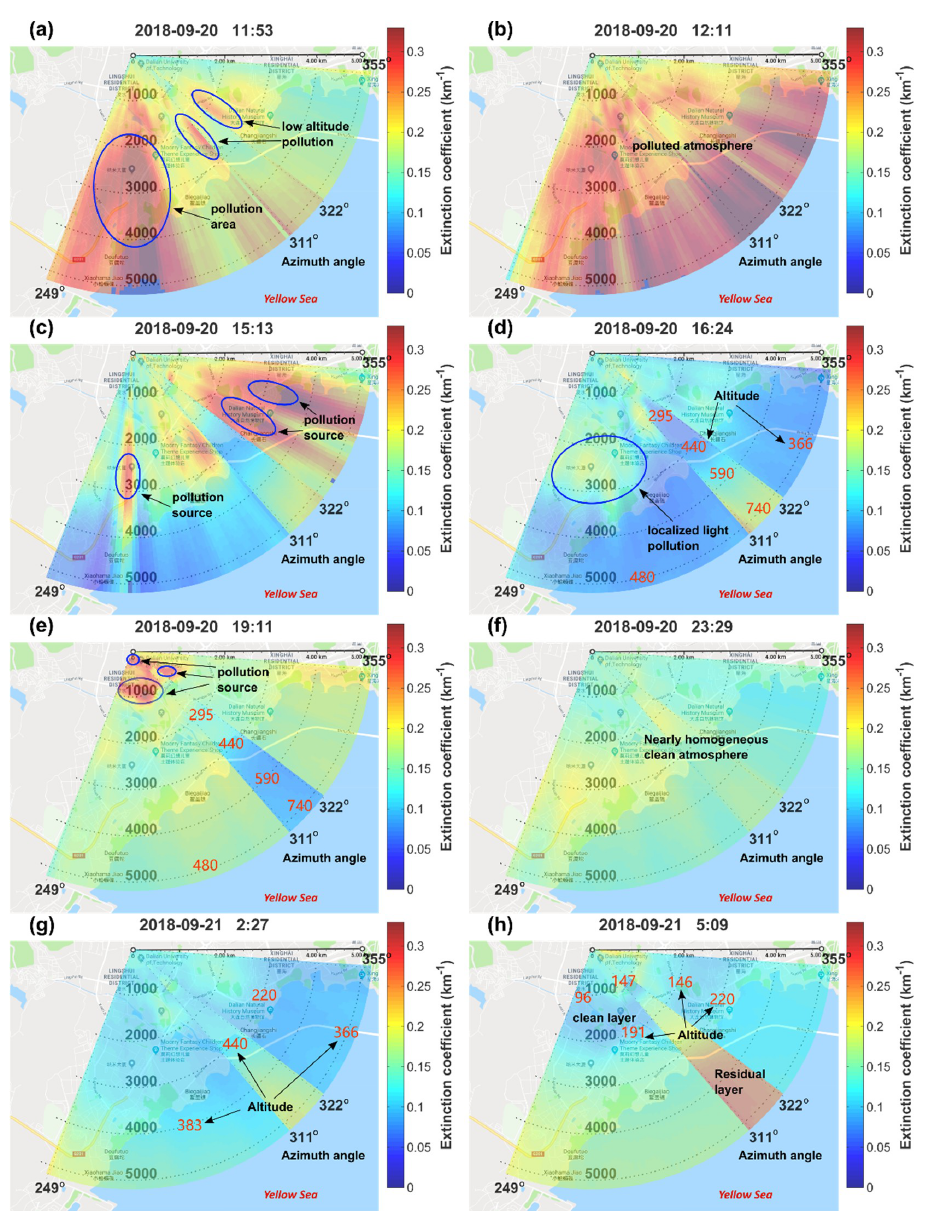
Figure 7. Horizontal scanning map of the atmospheric extinction coefficient measured at ( a ) 11:53, 2018-09-20, ( b ) 12:11, 2018-09-20, ( c ) 15:13, 2018-09-20, ( d ) 16:24 2018-09-20, ( e ) 19:11 2018-09-20, ( f ) 01:22, 2018-09-20, ( g ) 02:27, 2018-09-21, and ( h ) 05:09, 2018-09-21. Location of the lidar system: 38˚53′00.7″N, 121˚31′37.2″E. The local times indicated in the sub figures are 8 hours ahead of the Universal Coordinated Time (UTC).